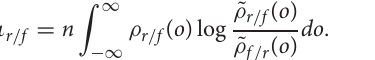
algorithm to decide on real or delusional with more information than would be afforded by a scalar observation. Suppose n